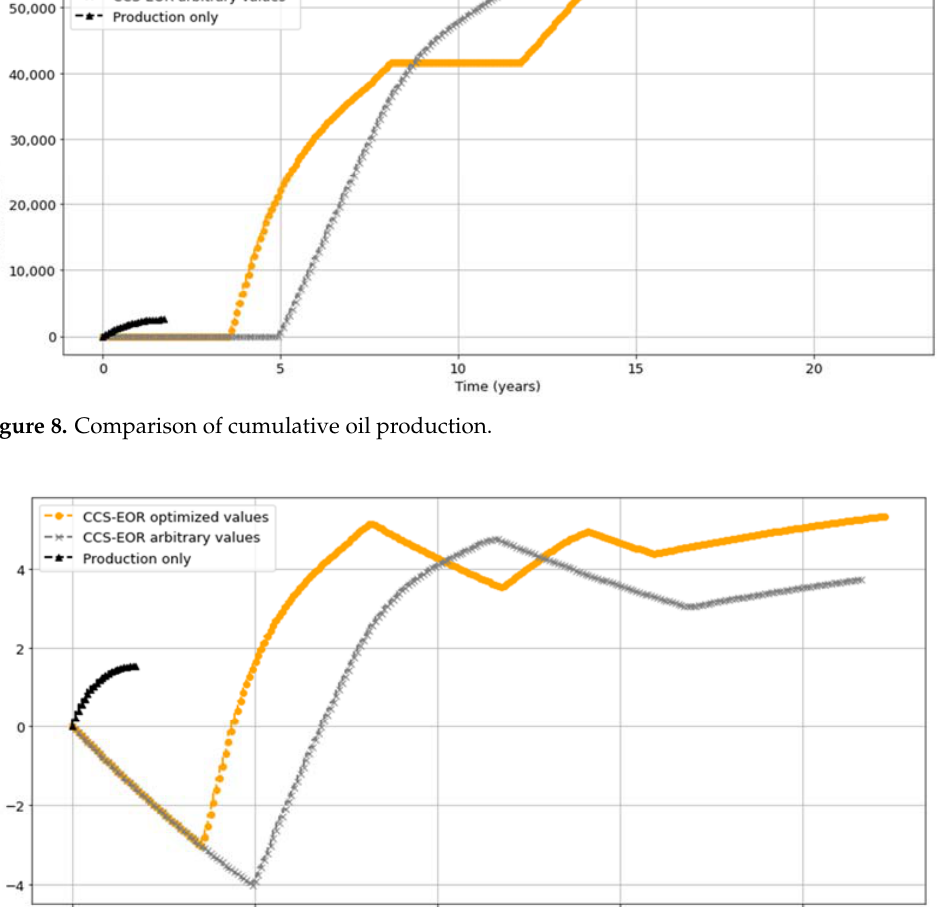
Figure 7. Comparison of the average reservoir pressure.